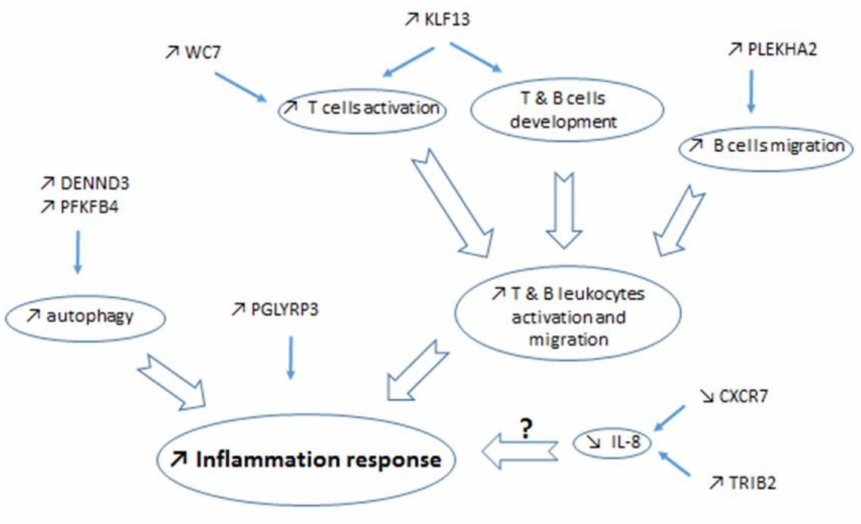
Figure 5. The potential actions of the differentially expressed genes identified in the comparison of mammary transcriptomes of restricted versus control cows during LPS challenge were from bioinformatics analyses and